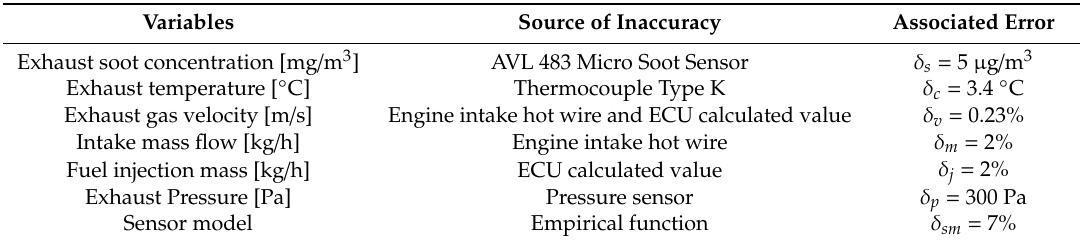
Table 6. Sensor model variables and associated errors.